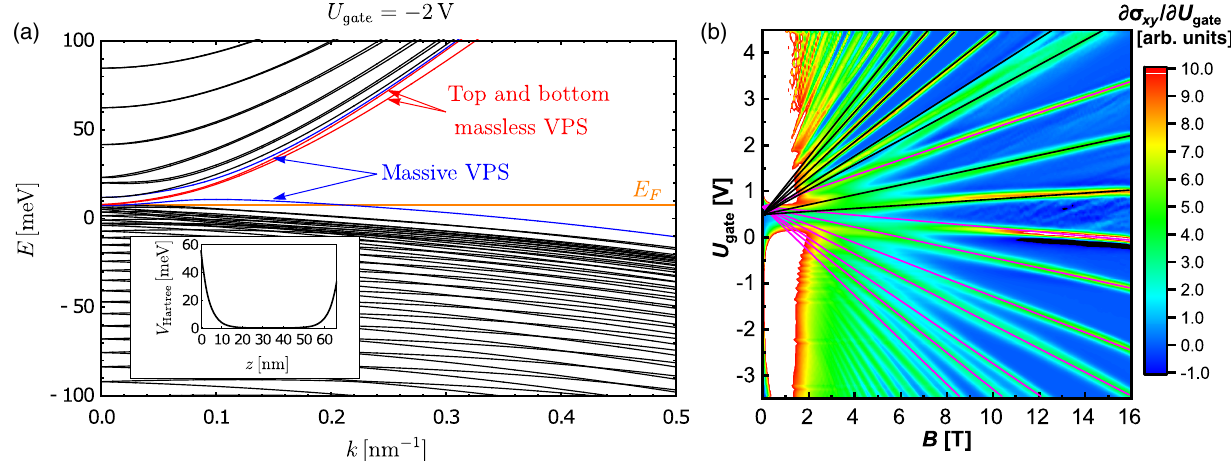
FIG. 7. (a) Calculated k · p band structure for a 66-nm-thick sample including bulk inversion asymmetry terms and a Hartree potential corresponding to an applied gate voltage of − 2 V ( n ¼ − 4 × 10 11 cm − 2 ). The Hartree potential is presented in the inset of (a). The massless Volkov-Pankratov states are shown in red, while the massive Volkov-Pankratov states are in blue. The bulk subbands are shown in black and the Fermi energy E F is indicated by the orange line. (b) Derivative of the Hall conductivity with respect to the gate voltage ( ∂ σ xy = ∂ U ) as a function of the applied gate voltage U and magnetic field B at T ¼ 0 . 02 K. The solid lines assign the experimental gate gate data to two types of Volkov-Pankratov surface (VPS) states: the massless ones (black) and massive ones